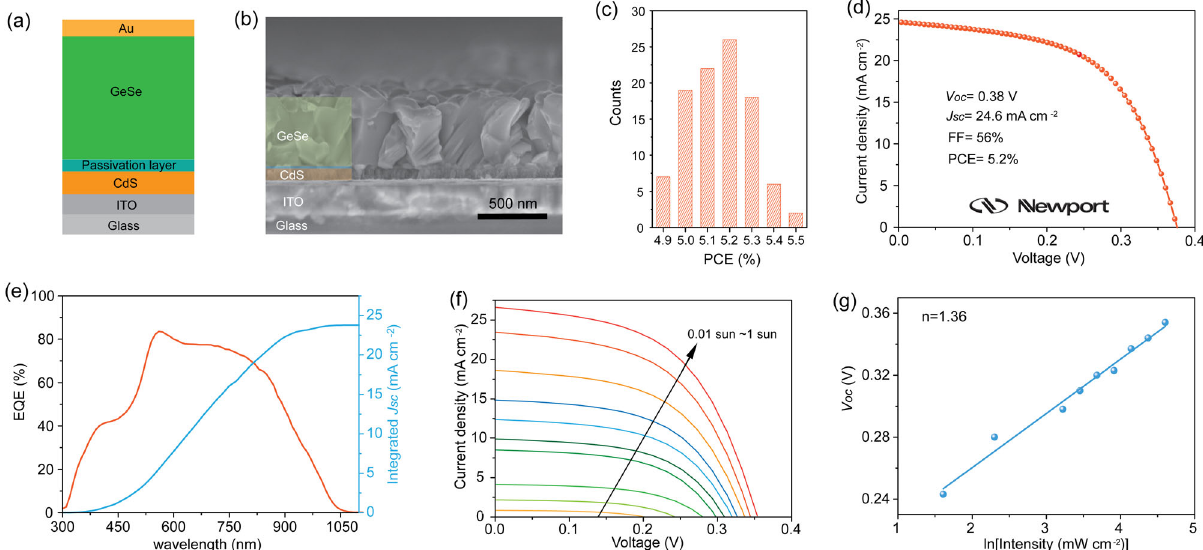
Fig. 3 Photovoltaic performance. a Schematic of GeSe thin- fi lm solar cell architecture. b Cross-sectional SEM image of the GeSe device. c Histogram of device ef fi ciencies obtained from 100 devices. d J-V curve and e EQE spectrum of the GeSe solar cell independently certi fi ed by Newport Corporation (Newport Corporation PV Laboratory, certi fi cate #1896). f J-V curves of a representative GeSe device measured under different intensities of simulated AM 1.5 G illumination. g Light intensity-dependent V oc of GeSe solar cells. Neutral-density fi lters (THORLABS) were used to adjust the light